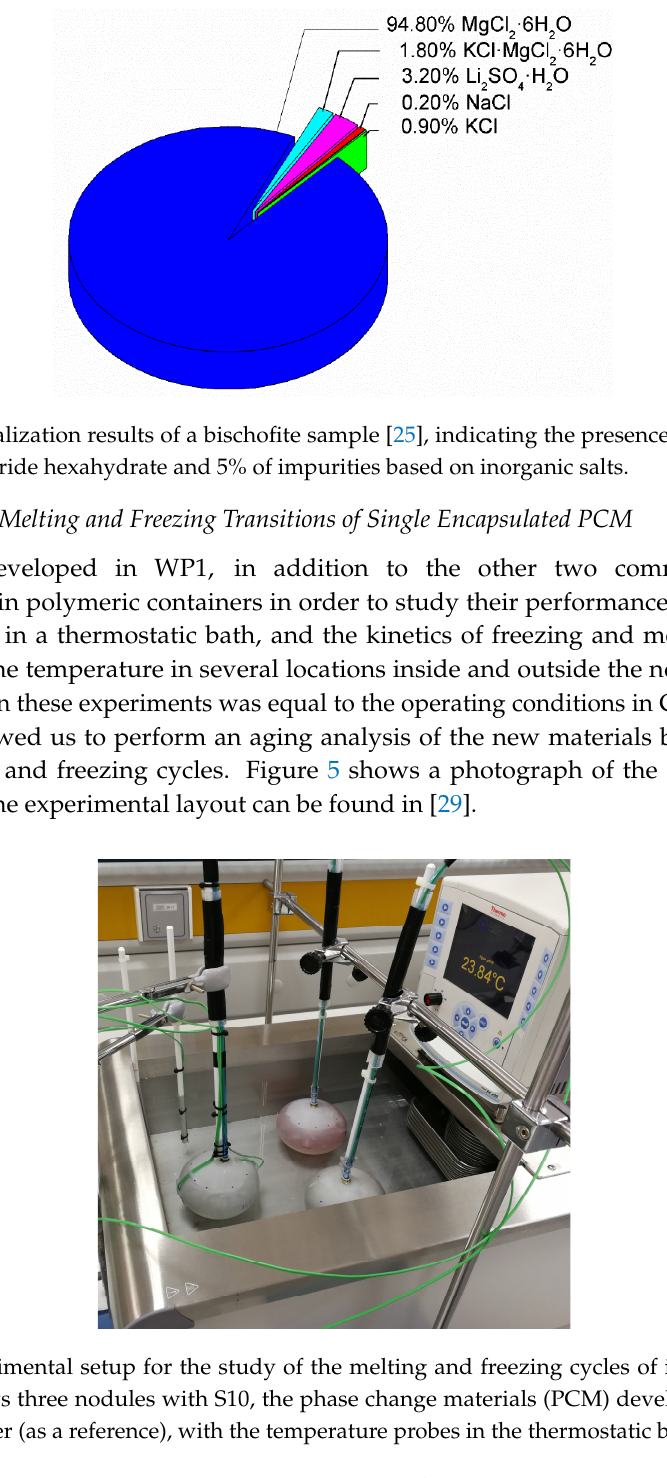
Figure 5. Experimental setup for the study of the melting and freezing cycles of isolated nodules. The image shows three nodules with S10, the phase change materials (PCM) developed within the project, and water (as a reference), with the temperature probes in the thermostatic bath.